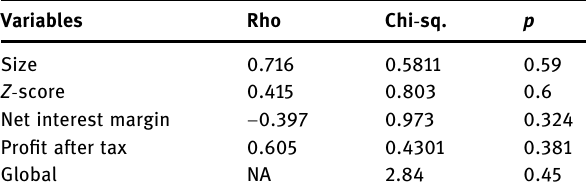
Table 8: Results for the test of proportionality